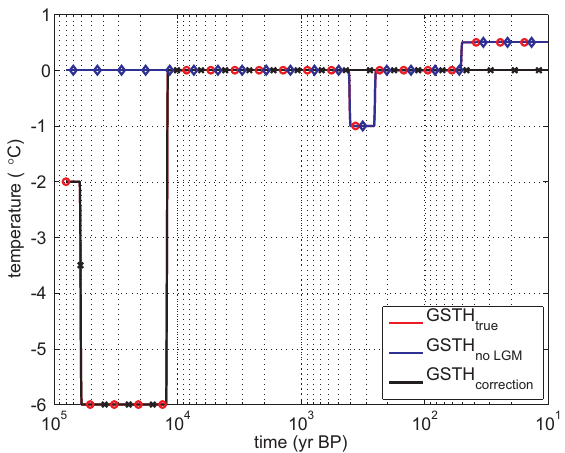
Fig. B1. GSTH used in the synthetic inversion experiments. BTPs derived from the true model (red) are named observed data, while the temperatures used for correction are derived from the black GSTH. For comparison, also synthetic observations assuming a constant behavior before the LIA are derived from the blue GSTH.